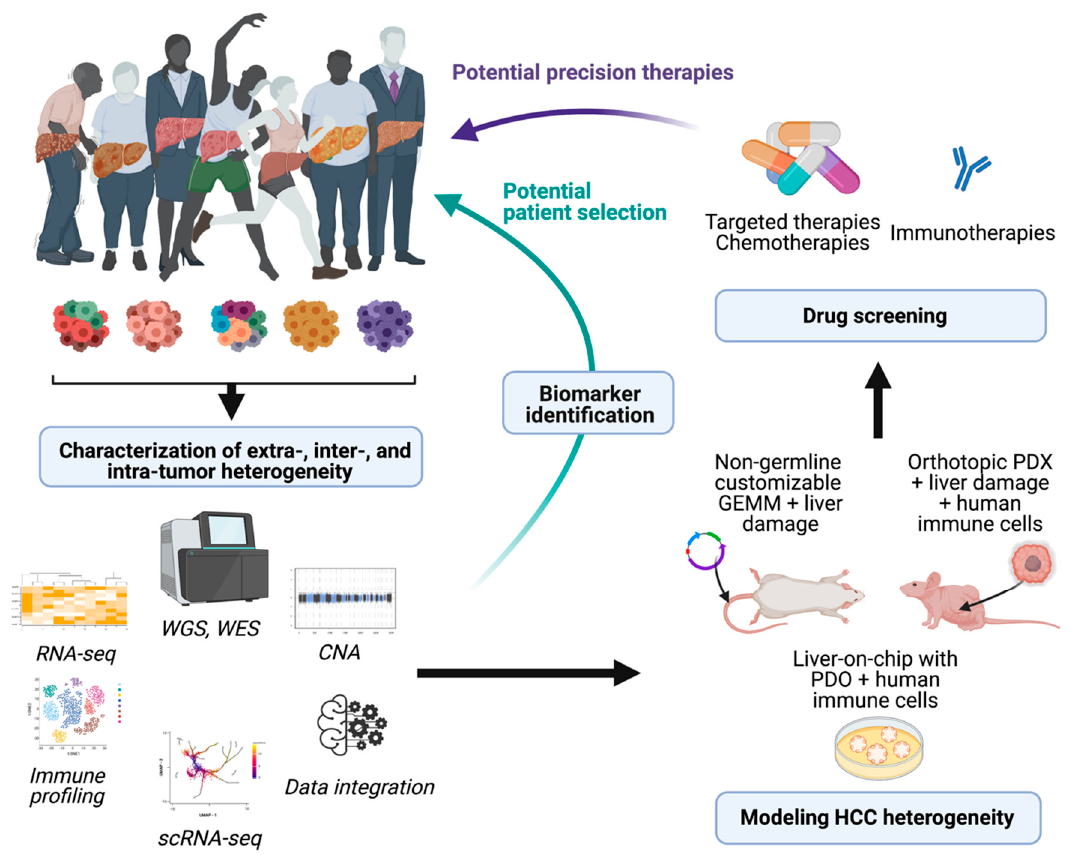
Figure 1. Potential implications of dissecting HCC heterogeneity. Implementation of high-throughput analysis to characterize HCC heterogeneity can provide useful biomarkers and pave the way for the development of novel models of HCC. The derived animal models and in vitro screenings that accurately recapitulate the complexity of this disease might represent powerful tools to test different drug sensitivities and potentially impact on the clinical management of patients. WGS, whole genome sequencing: WES, whole exome sequencing; CNA, copy number alteration; scRNA-seq, single-cell RNA-seq; PDX, patient-derived xenografts; PDO, patient-derived organoids. Figure prepared with Biorender.